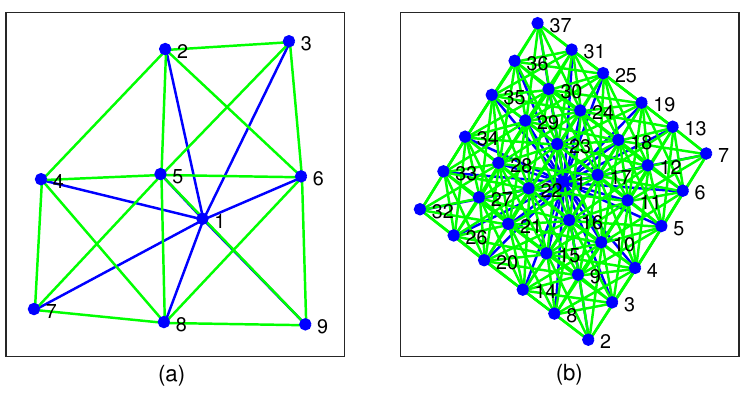
Figure 2. Simulated scenarios: ( a ) 9-BS network, and ( b ) 37-BS network. Blue lines refer fixed communication links between the SCBSs and the MBS; and green lines refer to dynamic cooperation links between the SCBSs.